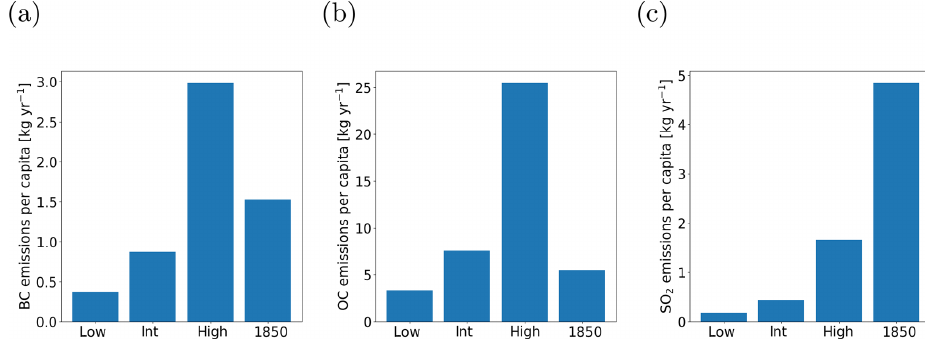
mediate, and high emission scenarios, respectively (Table